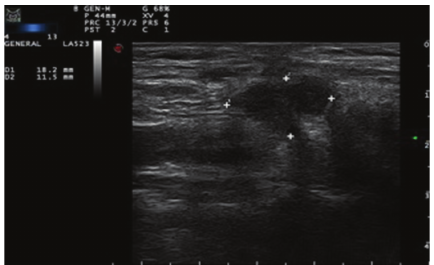
Figure 1: Hypoechogenic and avascular mass compatible with thyroidal remains.